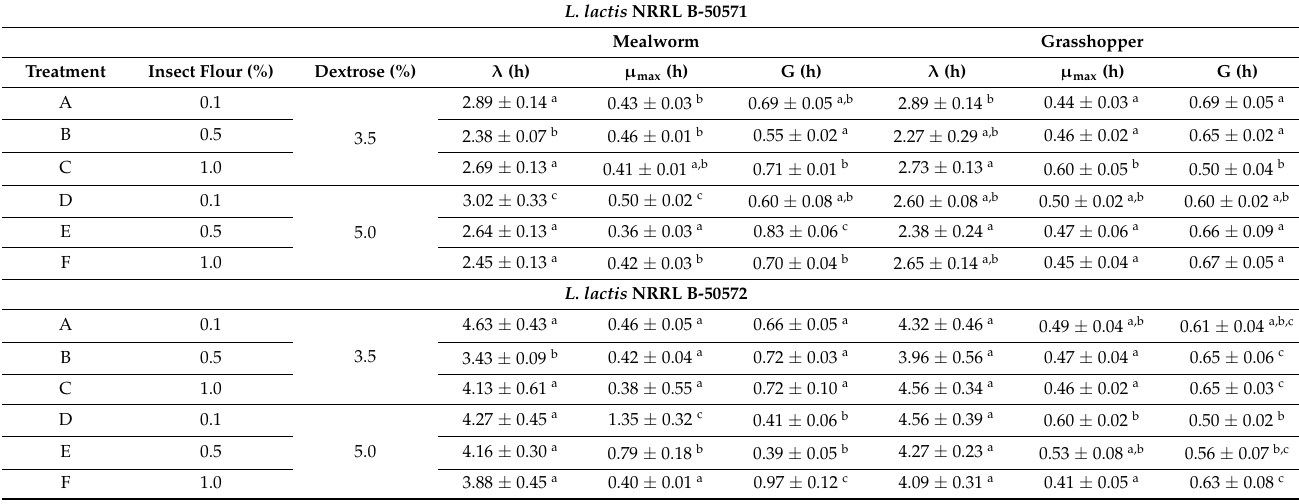
Table 1. The kinetic parameters obtained for the selection of the best growth conditions for L. lactis into edible insect flours. L. lactis NRRL B-50571 Mealworm